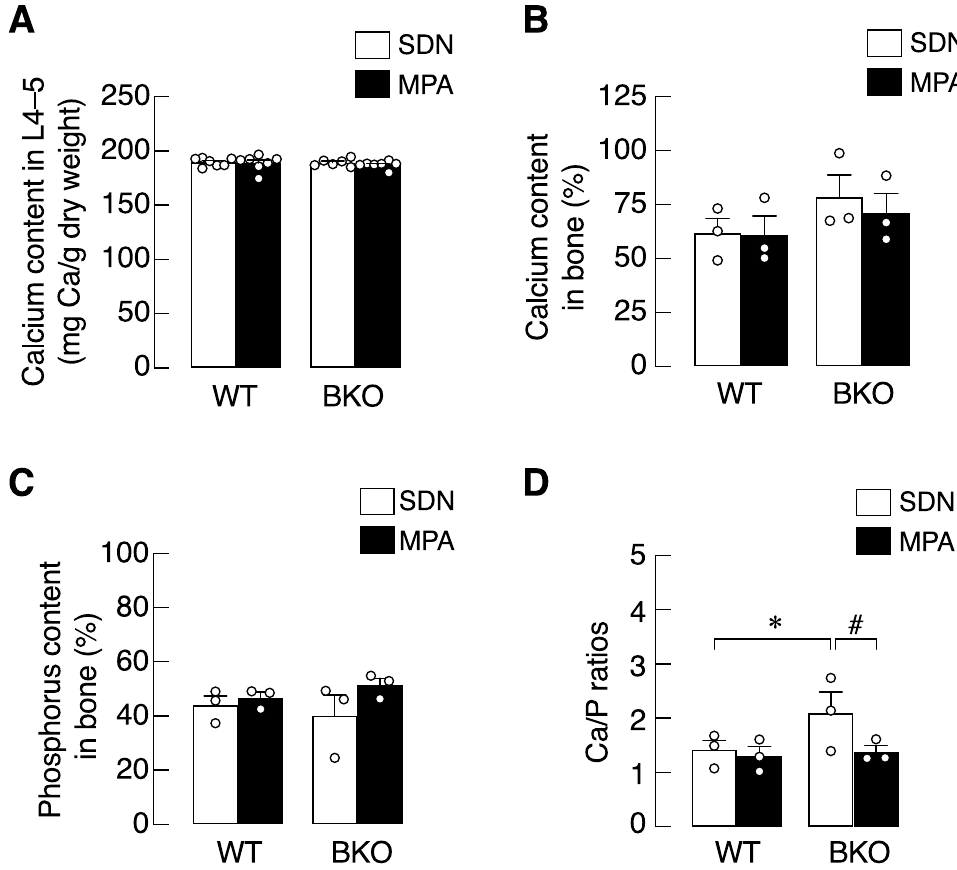
Figure 5. Calcium and phosphorus contents in bone from β-globin knockout (BKO) and wild-type (WT) mice after mild-intensity physical activity (MPA) training or sedentary (SDN) period. ( A ) Calcium content in lumbar vertebrae (L4-5) normalized by tissue dry weight (n = 6–7). ( B – D ) Calcium content, phosphorus content, and calcium/phosphate ratio are analyzed by FAAS and GFAAS (n = 3). Values are means ± SE. * P < 0.05 vs. corresponding age-matched WT group. # P < 0.05 vs. SDN